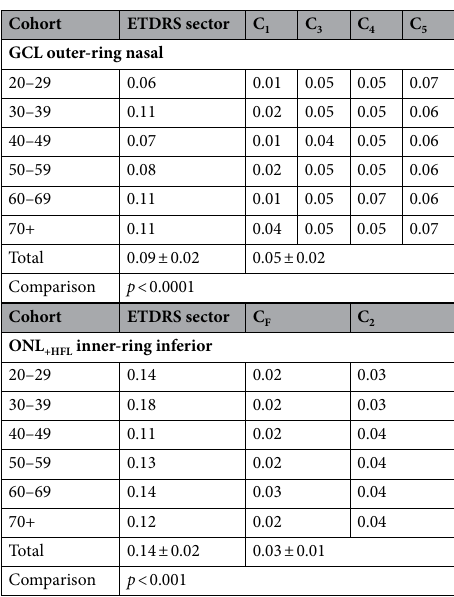
Table 3. ETDRS sectors versus corresponding grid-wise clusters. Values expressed are the coefficients of variation. Totals are expressed as mean ± standard deviation. Coefficients of variation for the grid-wise clusters are calculated from Supplementary Table 9. ETDRS, Early Treatment for Diabetic Retinopathy Study; C F , 1…5 , foveal cluster and cluster 1 to